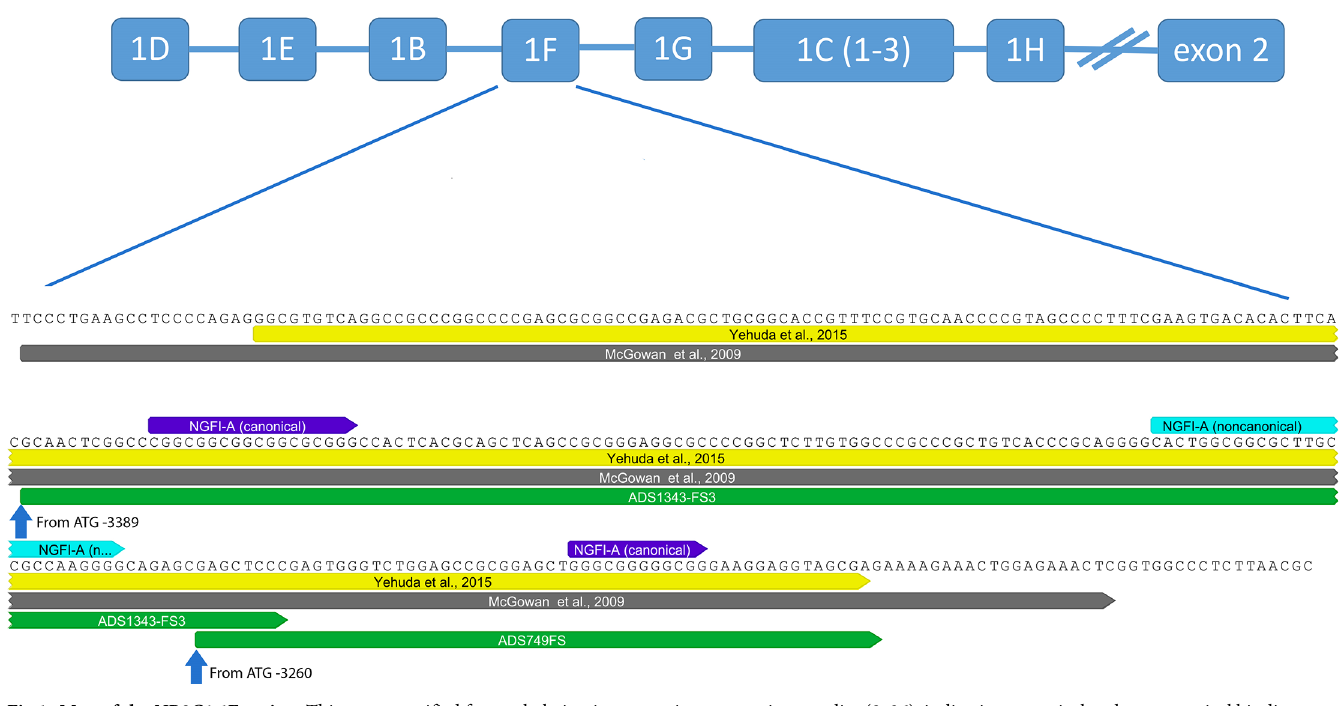
PLOS ONE | https://doi.org/10.1371/journal.pone.0192222 February 7,